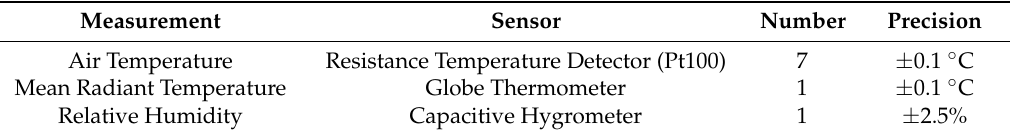
Table 2. List of sensors used for measuring the environmental variables inside the test room. Measurement Sensor Number Precision Air Temperature Mean Radiant Temperature Relative